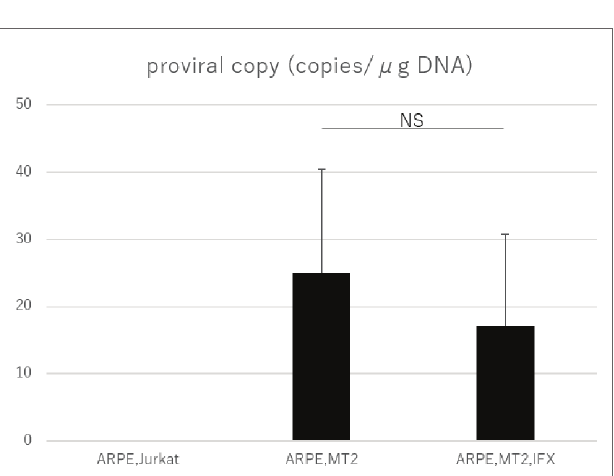
FIGURE 4 | PVL in ARPE-19 cells co-cultured with Jurkat, MT2, or MT2 treated with IFX. The PVL of HTLV-1-infected ARPE-19 is not increased, but is slightly decreased by IFX. Error bars represent standard deviations (NS, not significant).